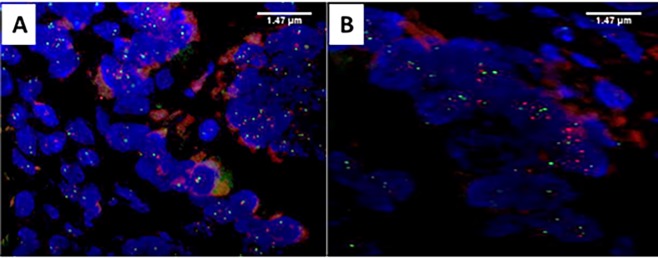
Fluorescence in situ hybridization using probes directed against Her2/neu in gastric adenocarcinoma (FISH, Her2 gene x 1000). A. Case of moderately differentiated adenocarcinoma negative for Her2 gene amplification, IHC Score 2+, Red signals (Her2/neu gene), green signals (chromosome enumeration probe 17 (CEP17)), blue signals (nuclei stained with DAPI) having Her2/CEP ratio between 1.8-2. B. Case of well differentiated adenocarcinoma, positive for Her2/neu gene amplification, showing red clusters (orange arrow) and was, IHC score 3+, having Her2/CEP ratio >2.